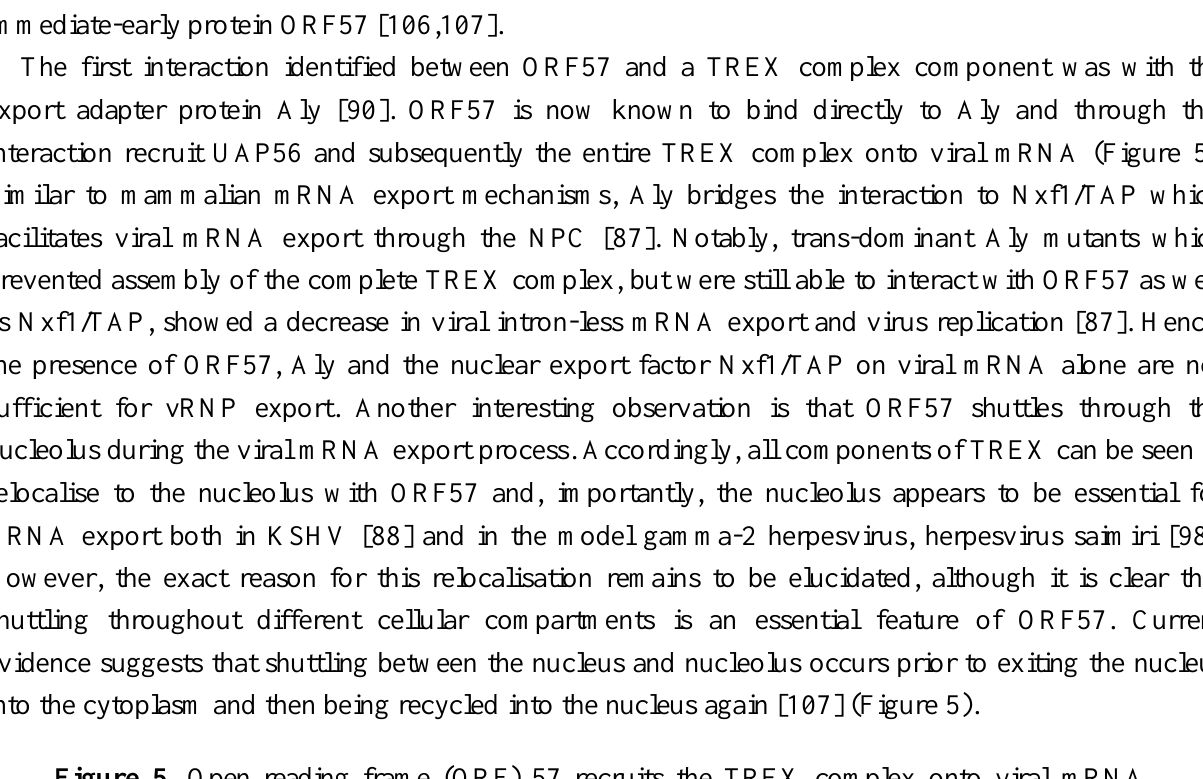
Figure 5. Open reading frame (ORF) 57 recruits the TREX complex onto viral mRNA, relocalises to the nucleolus and leaves the nucleus through the